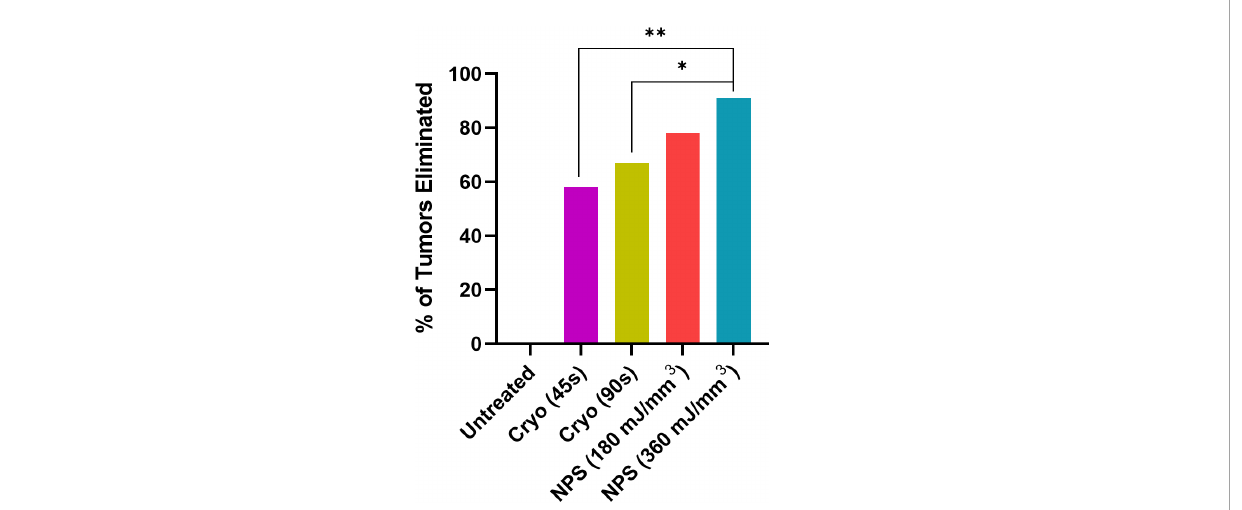
FIGURE 5 The percentage of tumors that were completely eliminated by the indicated treatments. Both low-mid (180 mJ/mm 3 ) and high (360 mJ/mm 3 ) NPS treatment groups exhibited higher rates of complete tumor elimination than either the low (45 s) or high (90 s) cryoablation treatment groups. (Chi square test: *p<0.05,